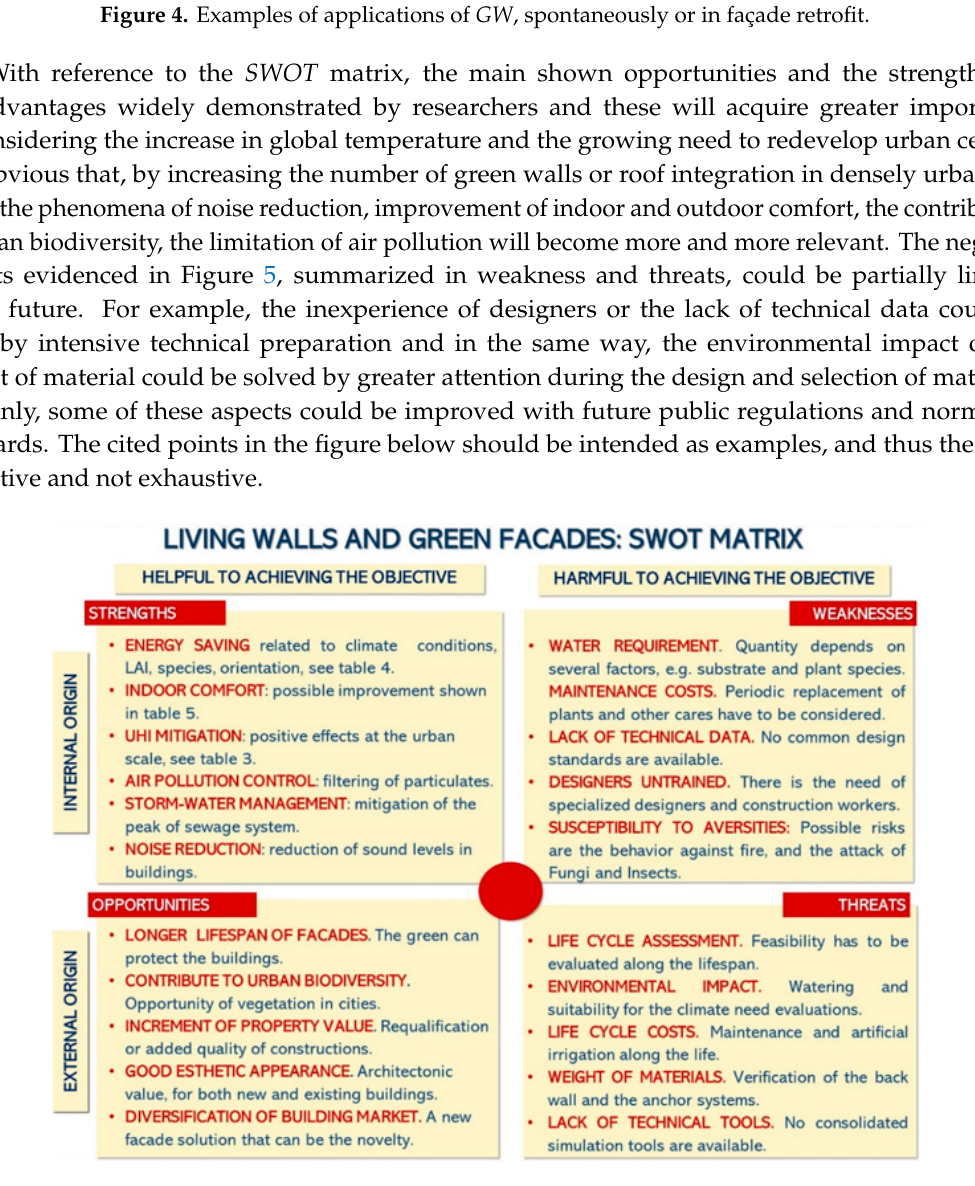
Figure 5. SWOT matrix for green vertical systems.